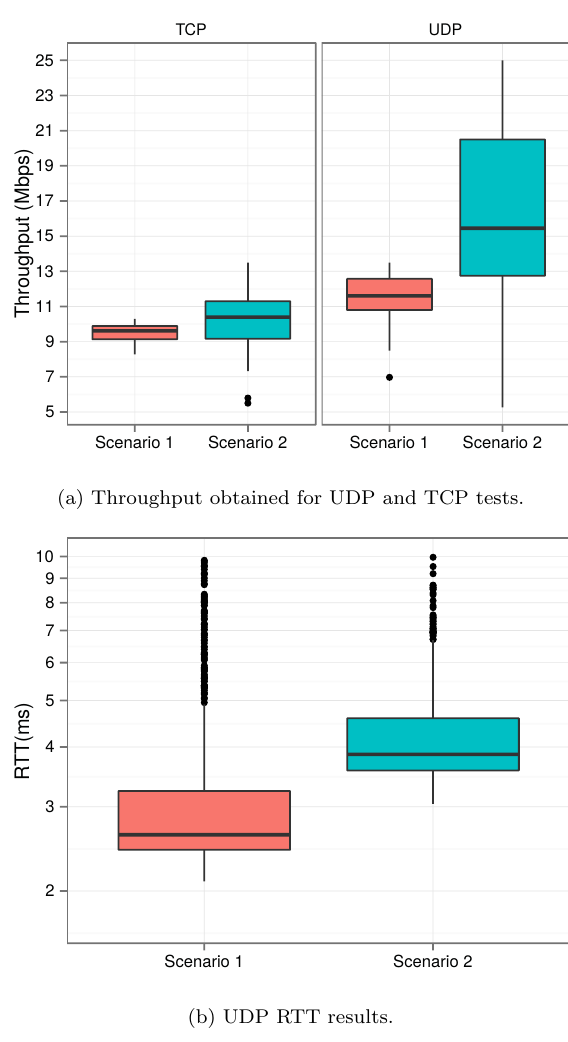
Figure 5: Direct VANET communication results.